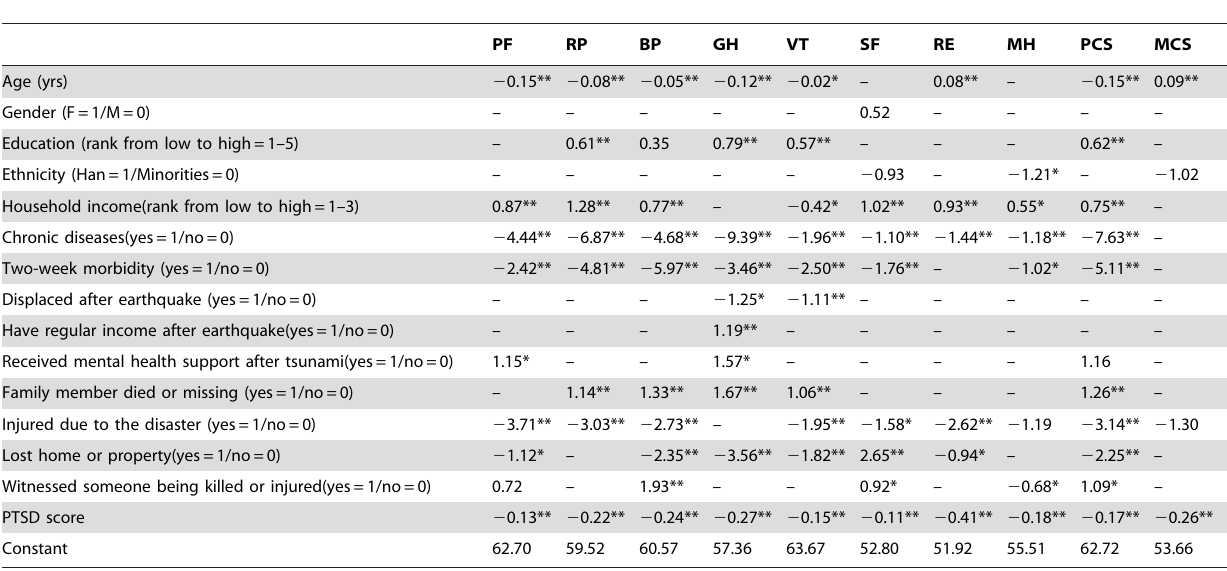
Table 4. Multiple linear regression analysis to predict scores of the subscales and domains of the SF-12 three years after the